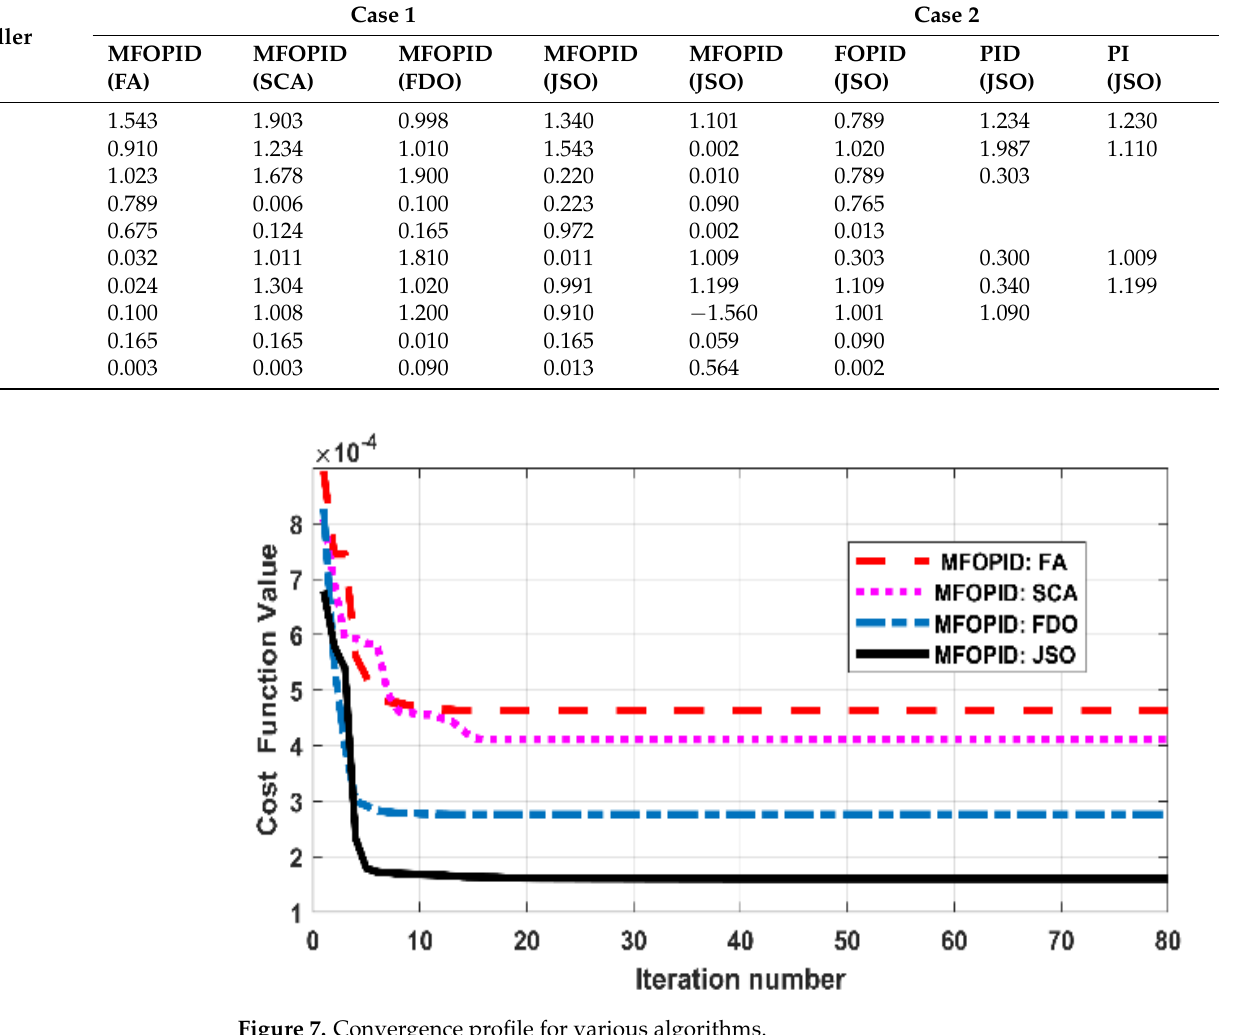
Figure 7. Convergence profile for various algorithms. Table 1. Optimal gains of the suggested controller considering case 1 and case 2.